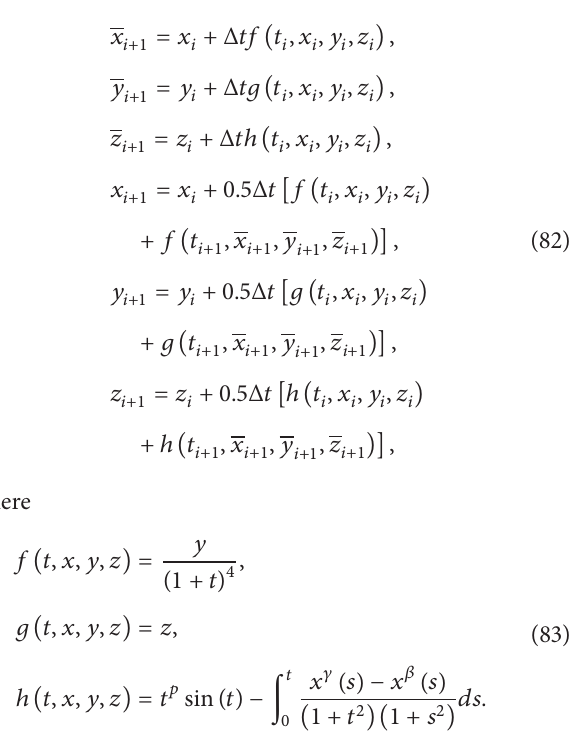
The prediction and correction steps of the modified